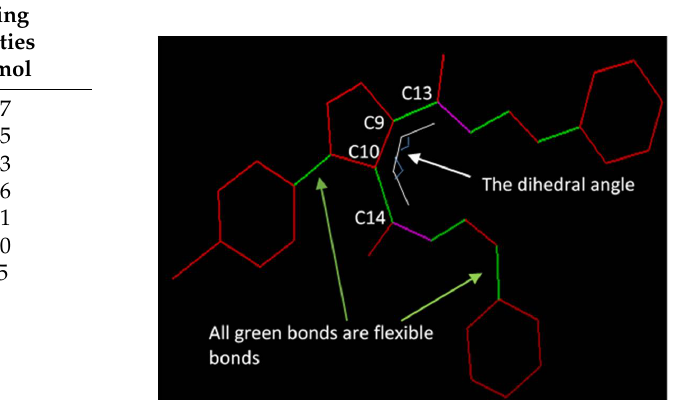
Table 3. Dihedral angles, number of flexible bonds, and binding affinities are presented here for comparison for the SBs 5a – g . Comp. No.